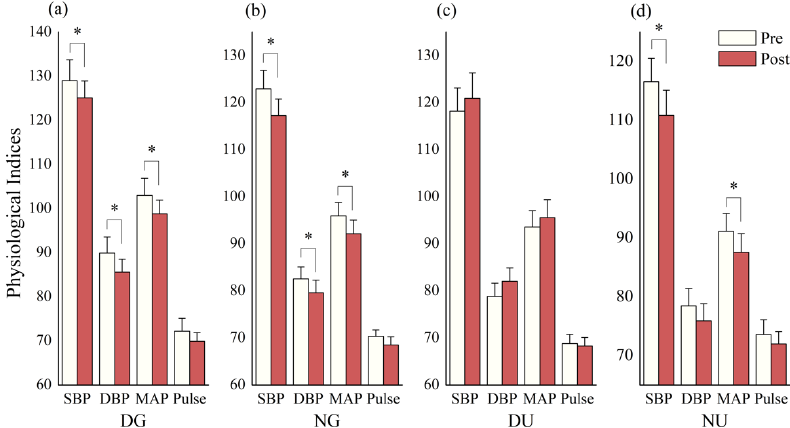
Figure 9. Outcomes of physiological measurements in: ( a ) daytime green walking; ( b ) nighttime green walking; ( c ) daytime urban walking; and ( d ) nighttime urban walking. The error bar represents standard error, and * represent p < 0.05. Analyzed using Paired t-test ( N = 12).